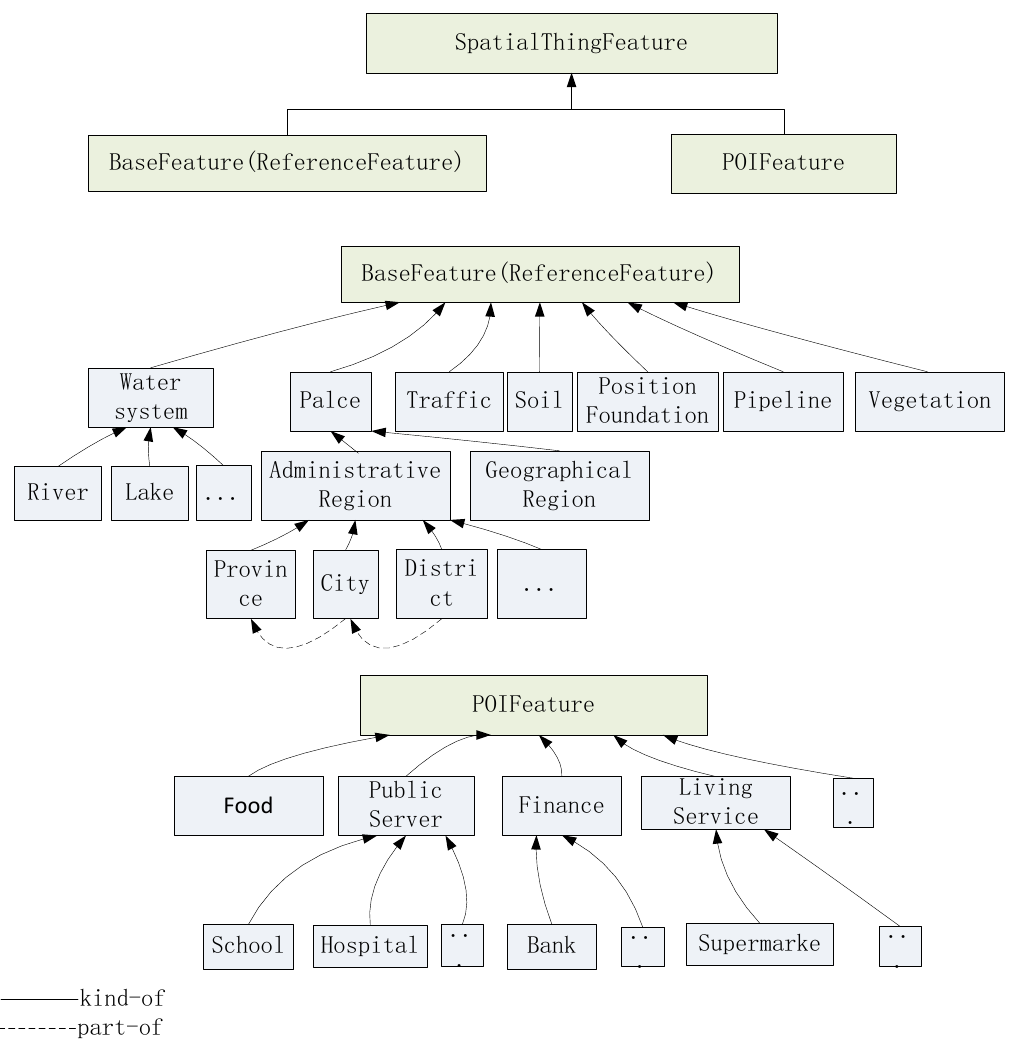
Figure 7. Structural classification of SpatialThingFeature .